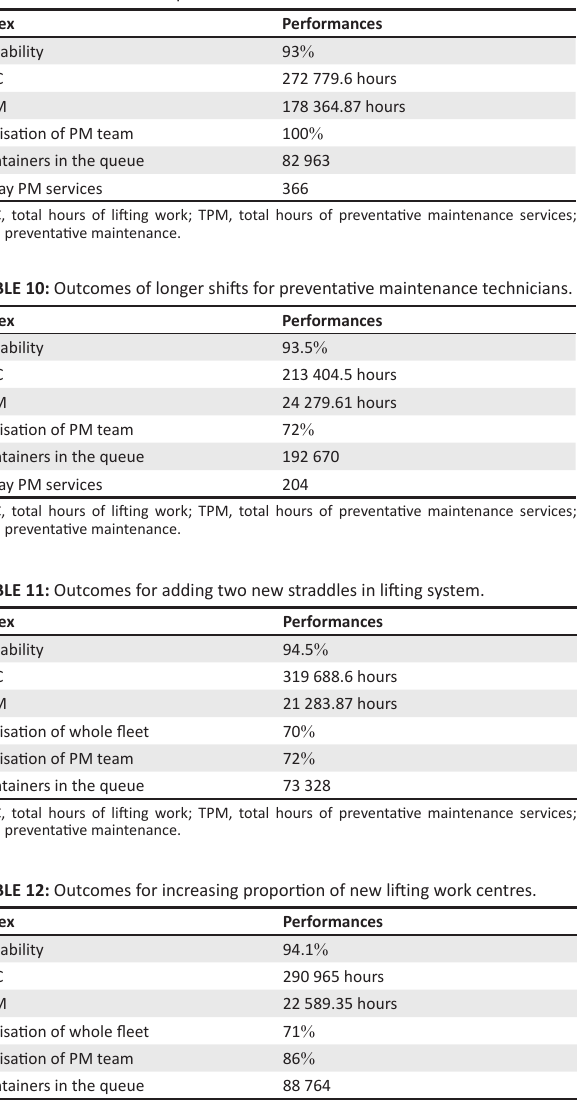
TABLE 6: Index values for the first model: Results of main indices.